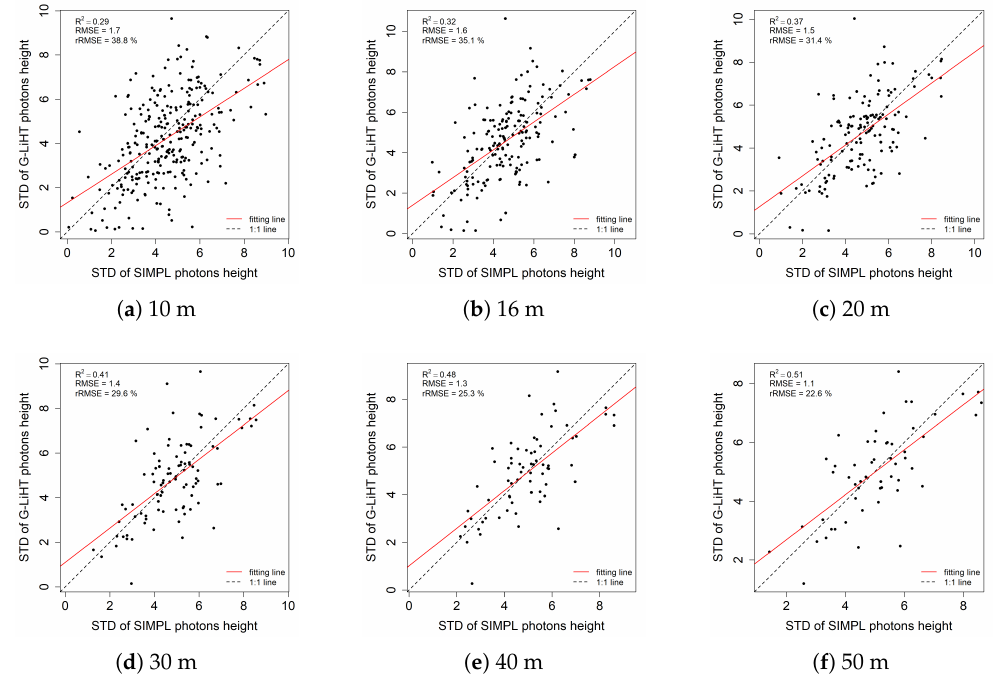
Figure 13. The relationship between the standard deviation of all photon heights from SIMPL and the standard deviation of all return heights from G-LiHT for different